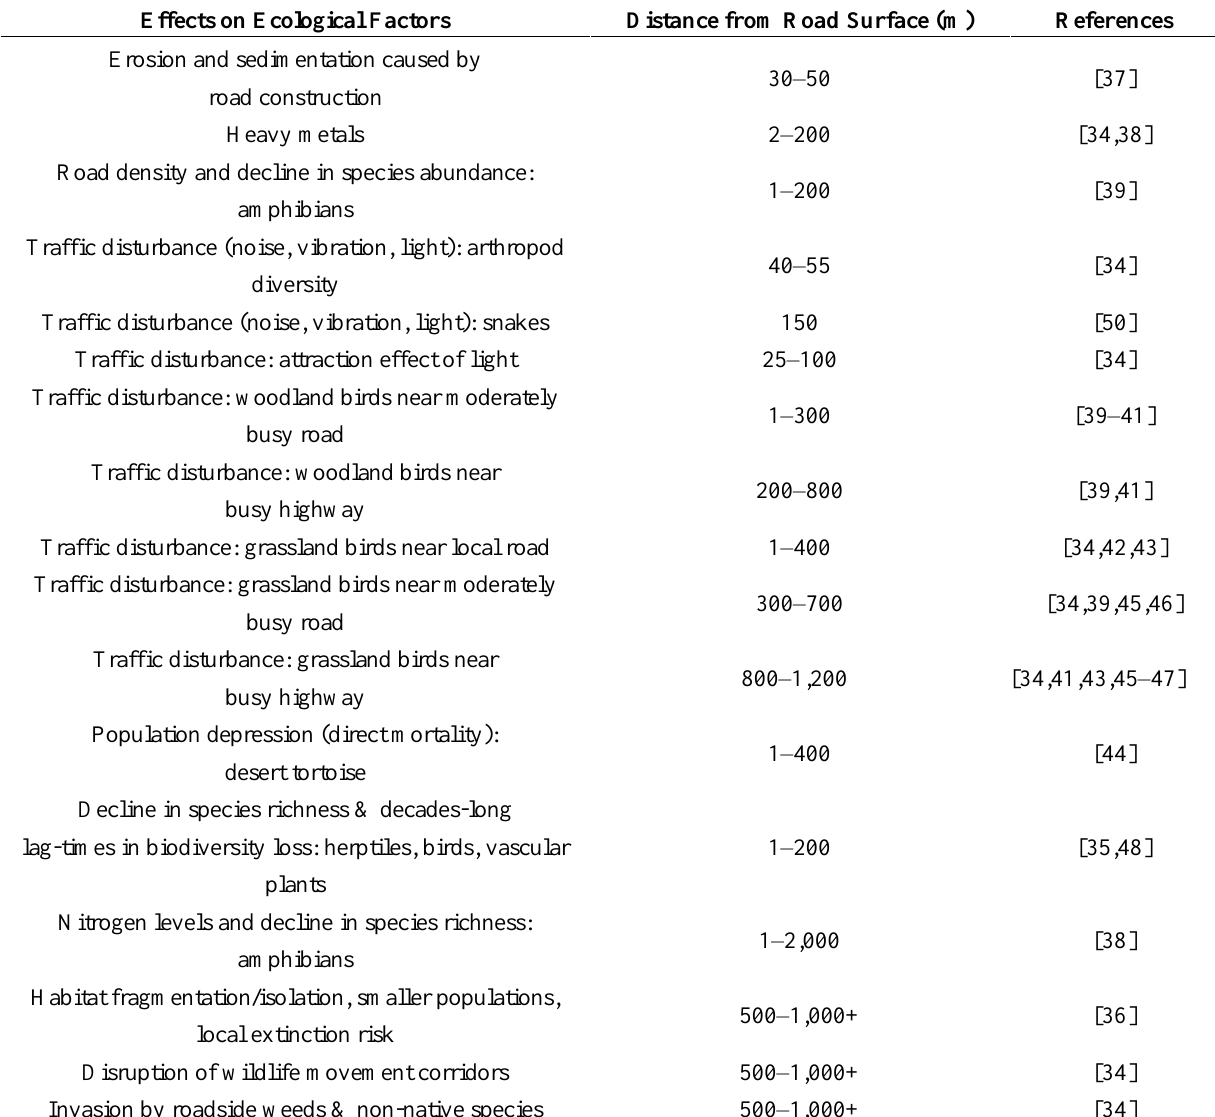
Table 2. Diffuse-effect distances from roads for a range of factors impacting ecosystem services and processes. Adapted from Forman et al .